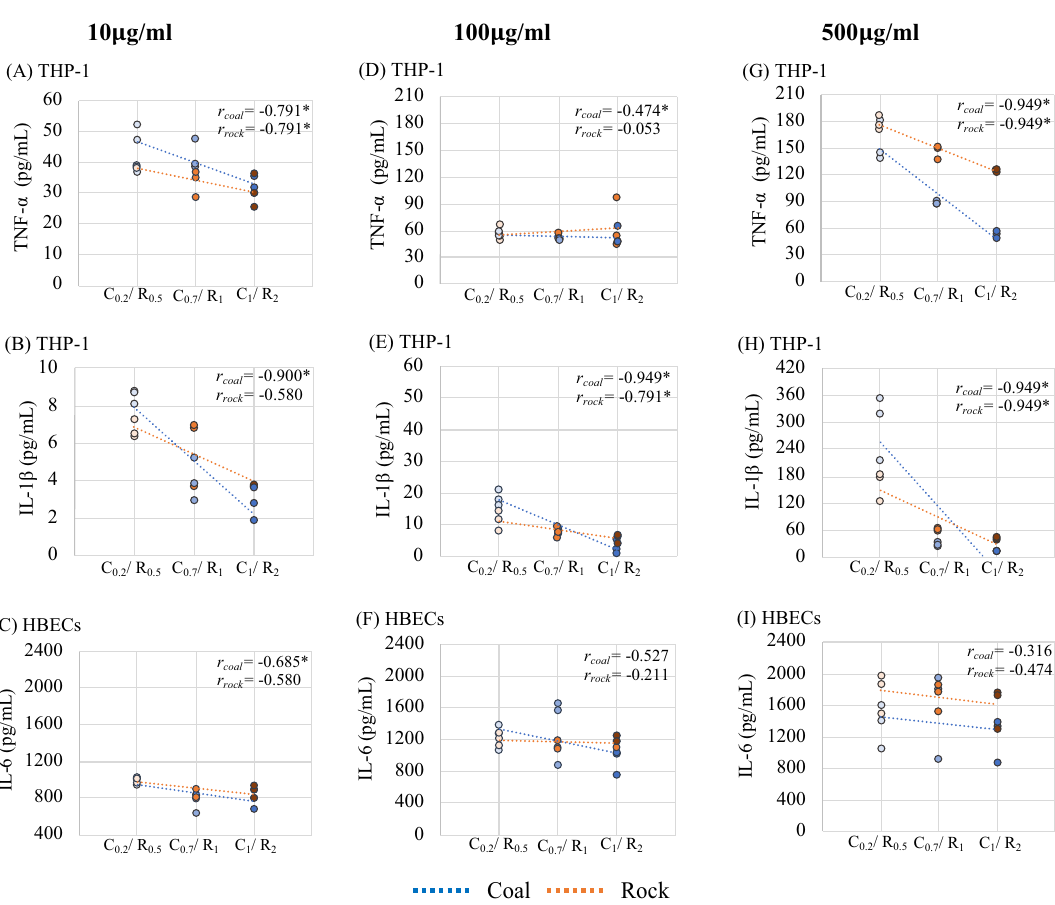
Figure 8. The correlation of inflammation cytokines (TNF-α, IL-1β, IL-6) between sized-mining dusts of three exposure concentration (10, 100, 500